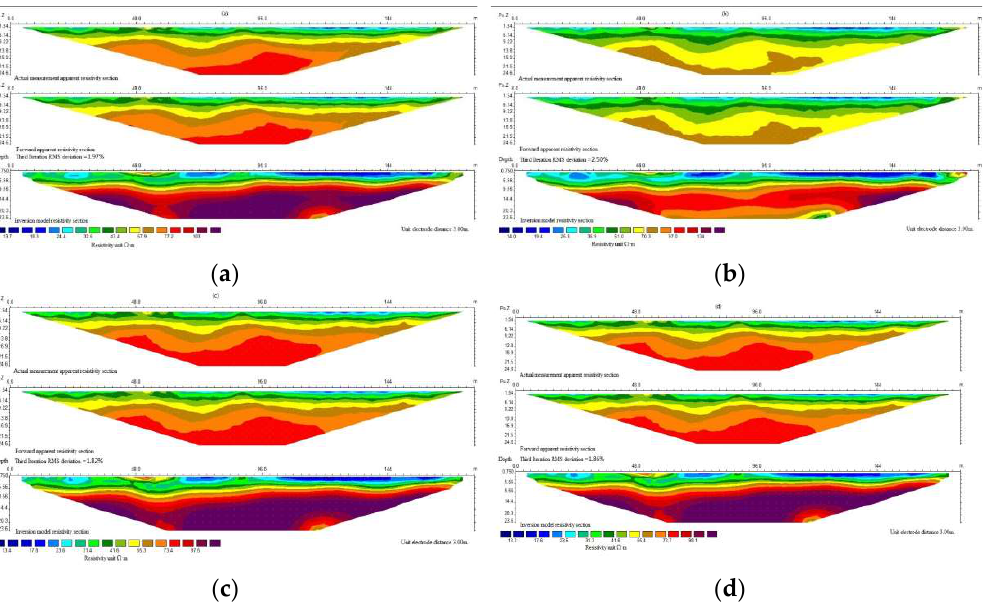
Figure 5. Apparent and inversed diagrams of resistivity of typical sections: ( a ) the apparent and inversed resistivity maps of the typical sections without a frozen soil layer; ( b ) the apparent and inversed resistivity maps across a partially frozen soil layer with a frozen soil thickness of 25 cm; ( c ) the apparent and inversed resistivity maps across a partially frozen soil layer with a frozen soil thickness of 50 cm; ( d ) the apparent and inversed resistivity maps with a 75 cm-deep frozen soil layer. Twenty-one drill holes, 70 to 100 m deep, were made in three rows to identify the strata and to verify the results of resistivity (Figure 6). The uniaxial compressive strength of natural semi-diagenetic rocks is generally less than 3 MPa. The characteristics of the rocks are shown in Table